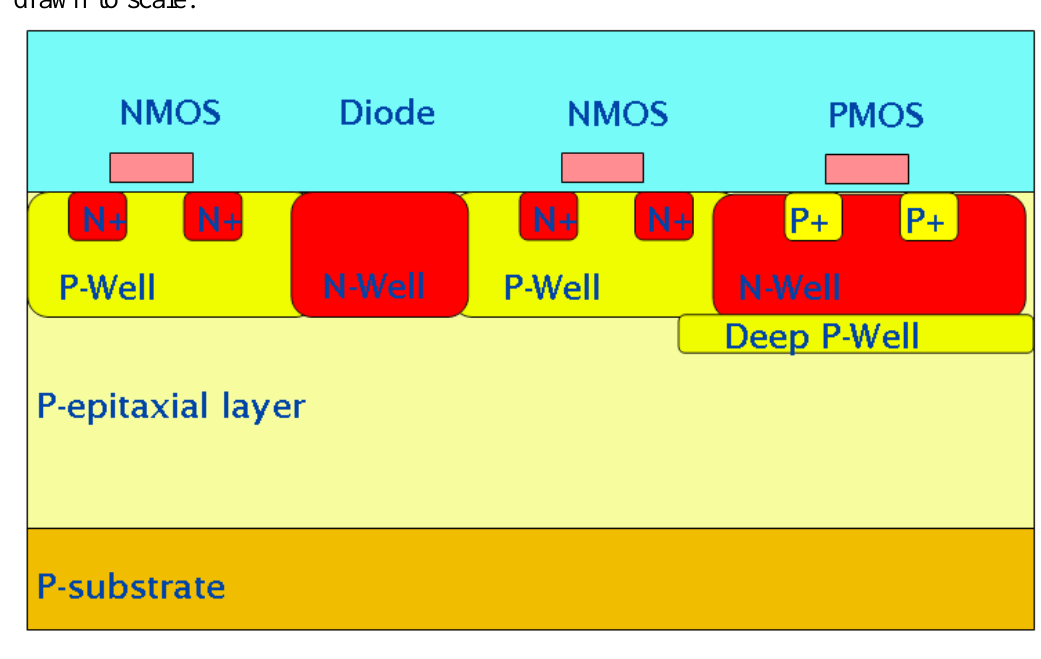
Figure 2. Schematic cross-section of a CMOS wafer with the deep P-well implant. Not drawn to